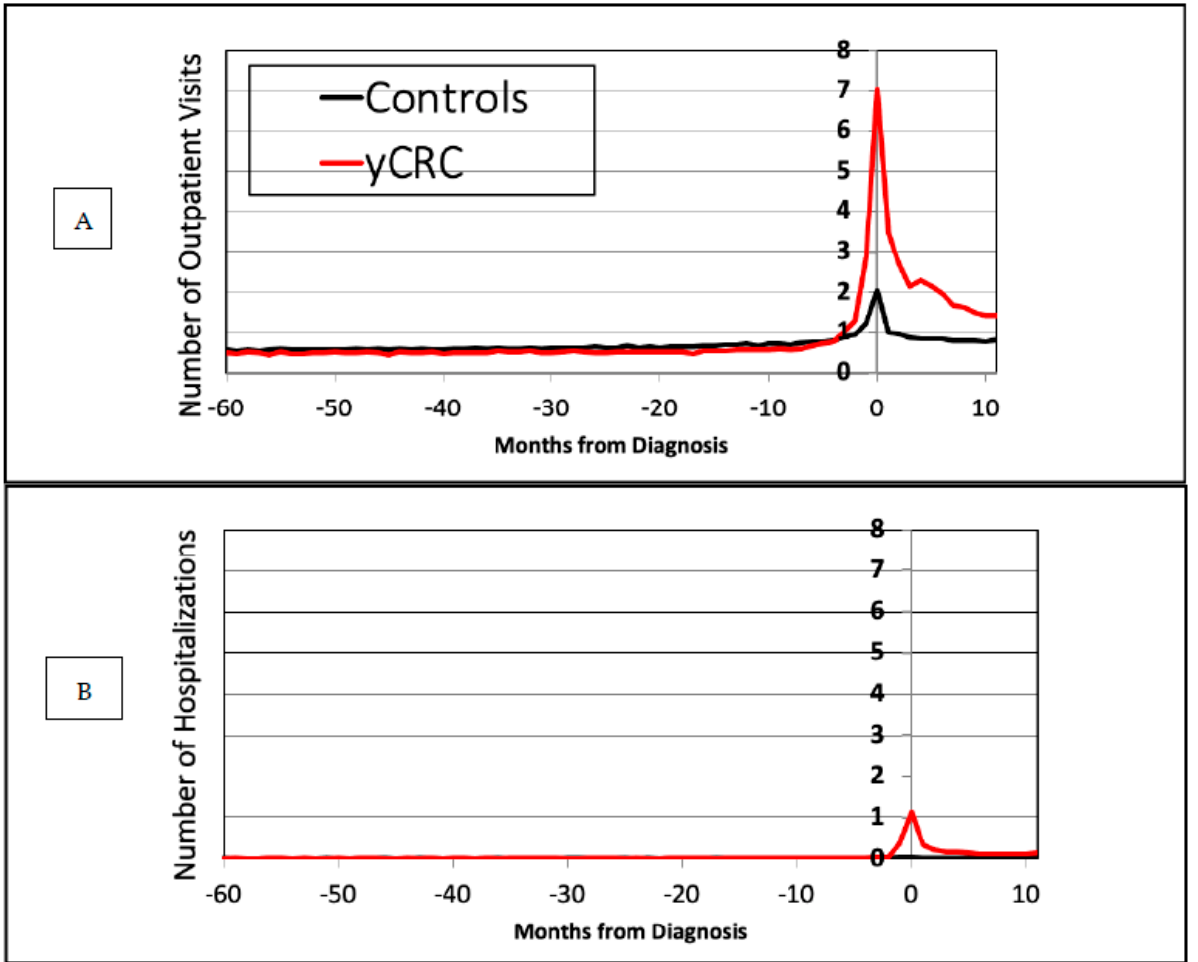
Figure 2. Patterns of healthcare utilization in terms of ( A ) outpatient visits and ( B ) hospitalizations for individuals with young-onset CRC and cancer-free controls (y-axis denotes number of visits and x-axis denotes months, with month 0 indicating ‘index date’). Table 2. Healthcare utilization among yCRC cases and cancer-free controls during prediagnosis period (years-5 to -1) and year of diagnosis (year 1).